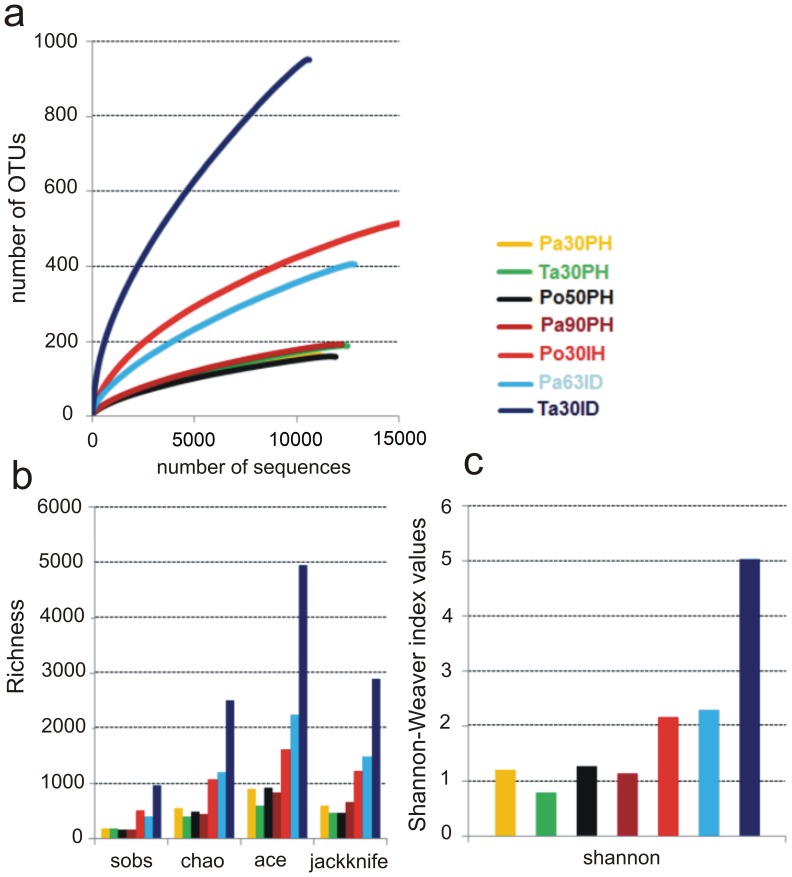
Bacterial diversity associated with P.
clavata.Alpha diversity metrics derived from 16S rDNA pyrosequencing of bacteria associated with P. clavata samples: (a) Rarefaction curves; (b) number of OTUs predicted (Chao1, Ace, jackknife) and observed (sobs); (c) Shannon-Weiner diversity of bacteria from each coral sample. OTU’s were grouped at >97% similarity based on mothur classified results.